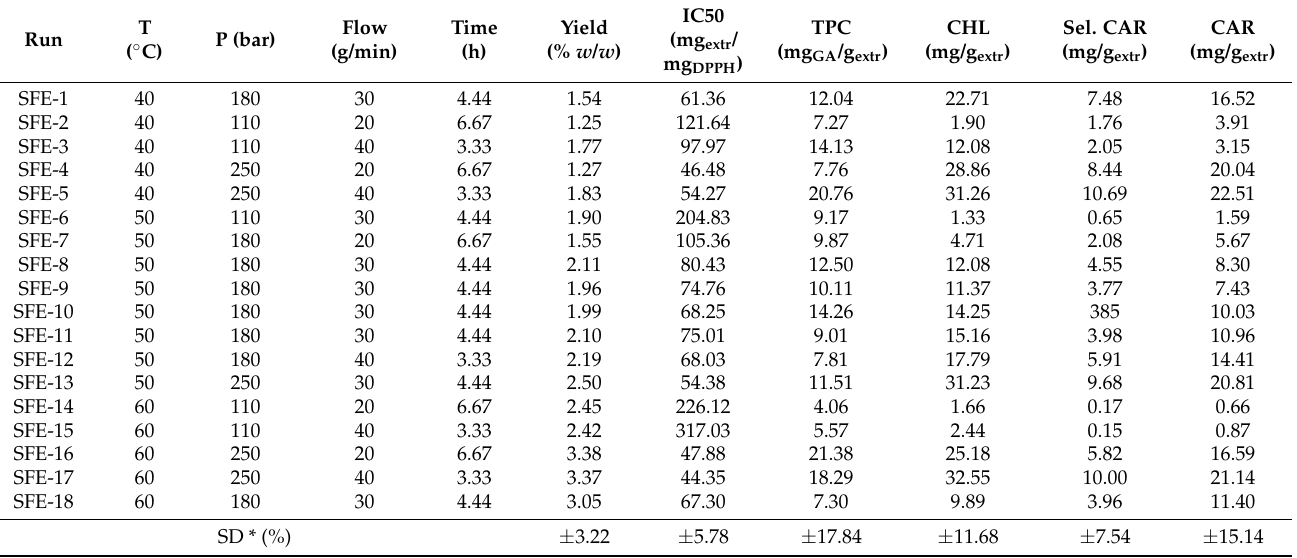
Table 1. The experimental responses of yield, antioxidant activity (IC50), total phenolic (TPC), chlorophyll (CHL), selected carotenoid (sel. CAR) and carotenoid (CAR)